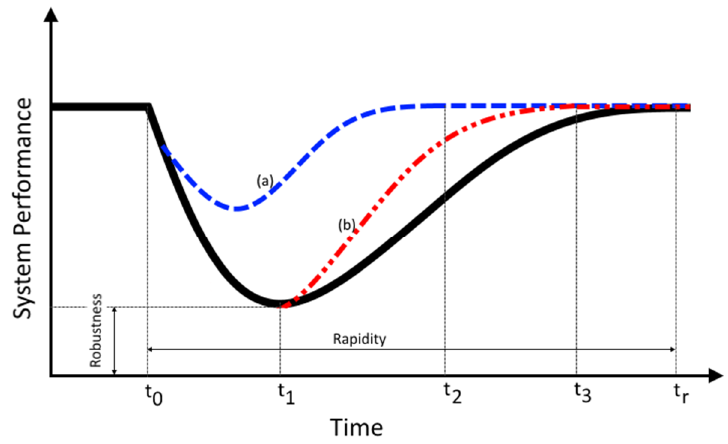
Figure 3. Generic representation of system performance (after